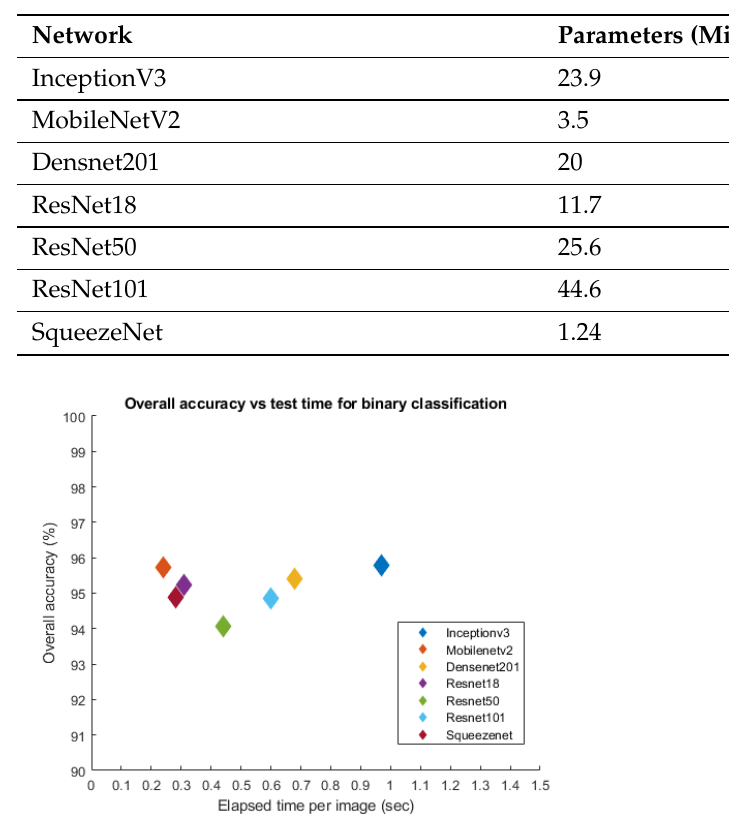
Figure 10. Confusion matrix for normal and thalassaemia classification for the best-performing model (InceptionV3). Table 4. Different trained CNN network parameters.